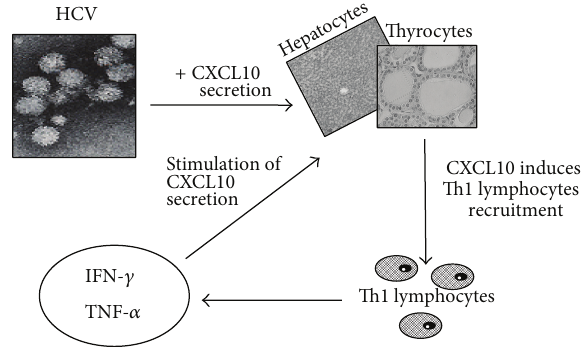
Figure 1: HCV thyroid infection may act by upregulating CXCL10 gene expression and secretion in thyrocytes recruiting Th1 lympho- cytesthatsecreteIFN- 𝛾 andTNF- 𝛼 .ThesecytokinesinduceCXCL10 secretion by thyrocytes, thus perpetuating the immune